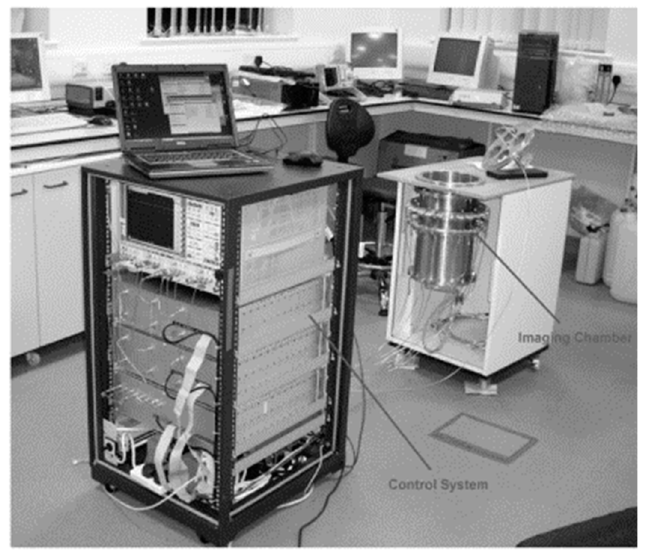
Figure 3. 2D microwave tomography (MWT) system for soft tissue imaging and physiological activity detection [44].